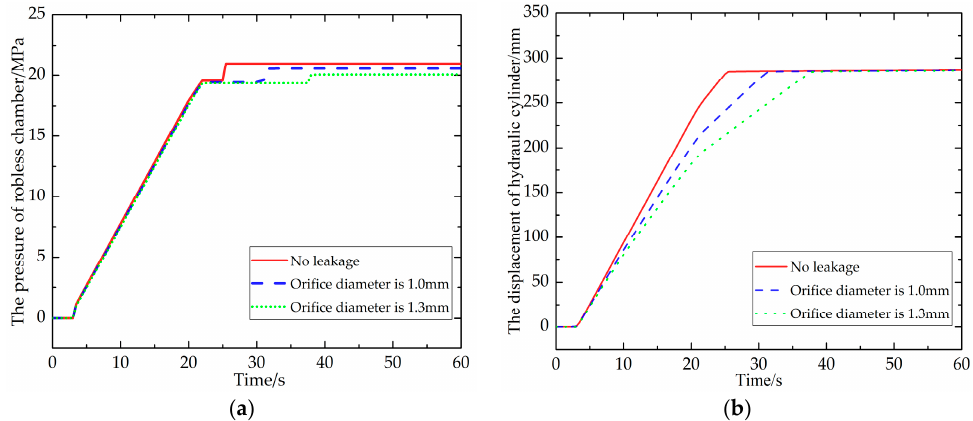
Figure 8. When the hydraulic cylinder was exposed to external leakage. ( a ) The pressure of the rodless chamber; ( b ) the displacement of the hydraulic cylinder.